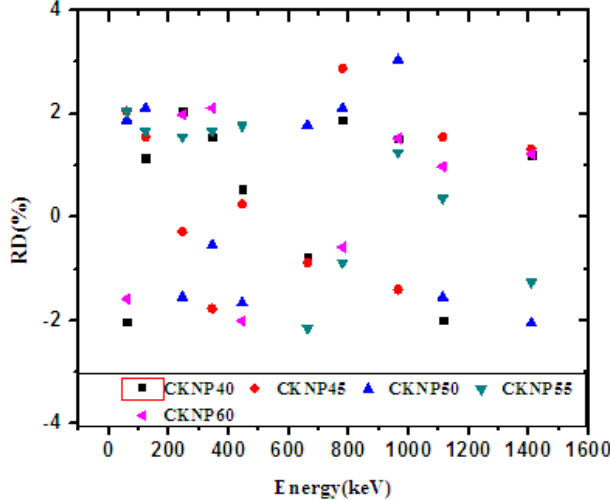
Figure 3. The relative difference between the mass attenuation coefficient obtained by experimental method and calculated by XCOM.